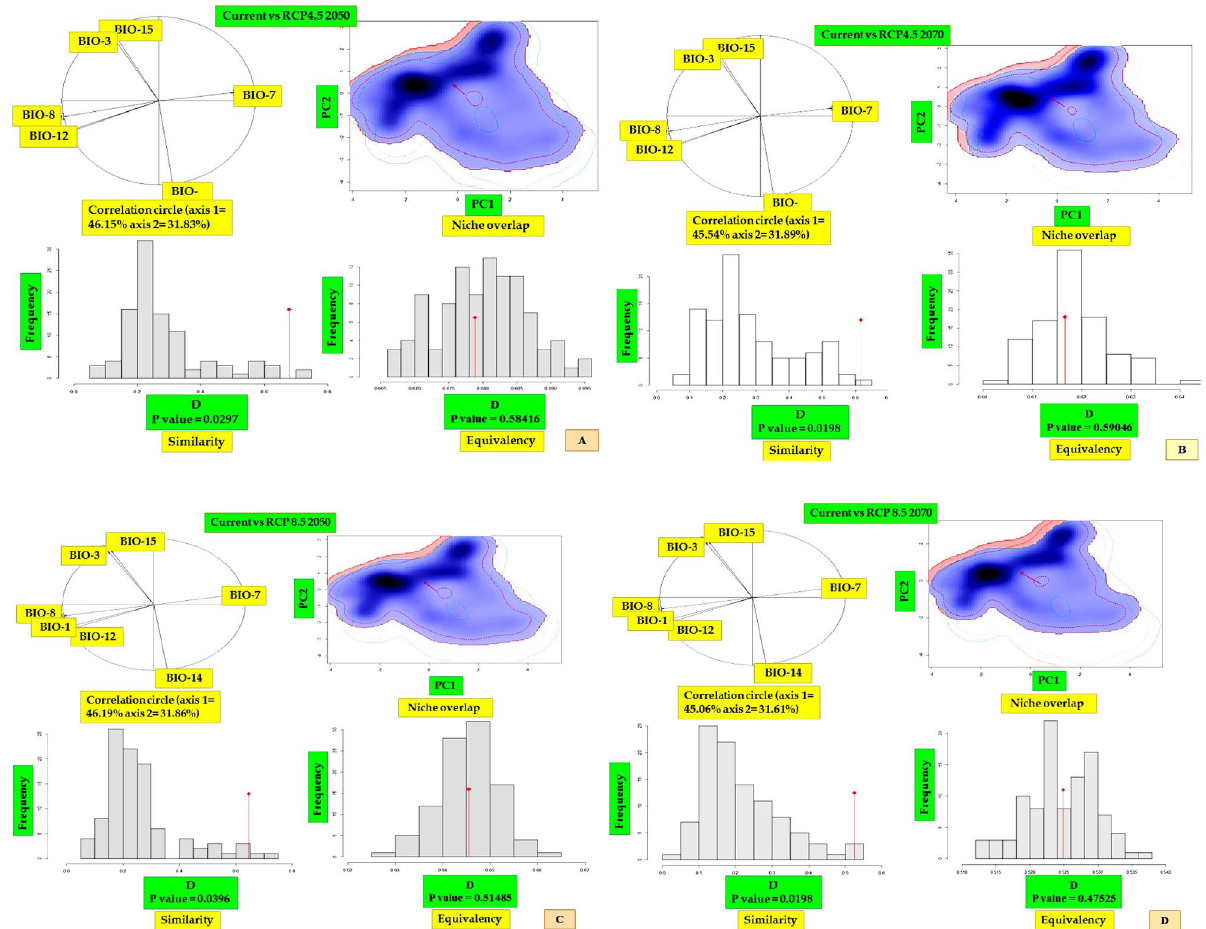
Figure 9. ( A – D ) Current and future climatic niches of Rheum webbianum . The correlation circle represents contribution of bioclimatic variables to the first two components main of the PCA-env analyses and the percentage of variation explained by each axis. The blue and red shadings represent density of species occurrence under current and future climatic scenarios. The bar plots represent niche the results of niche equivalency and similarity tests. The red arrow represents the shift in the climatic niche between current and future climatic conditions.